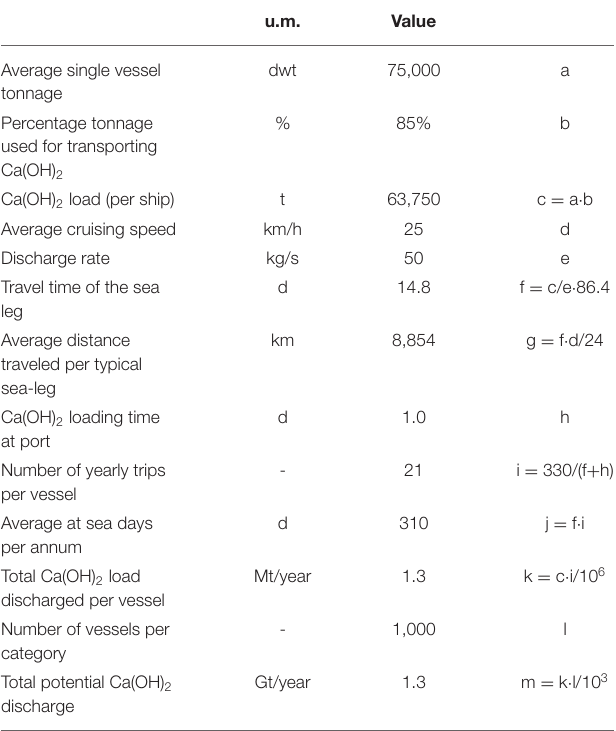
TABLE 7 | Assessment of the potential SL discharge from new dedicated ships.